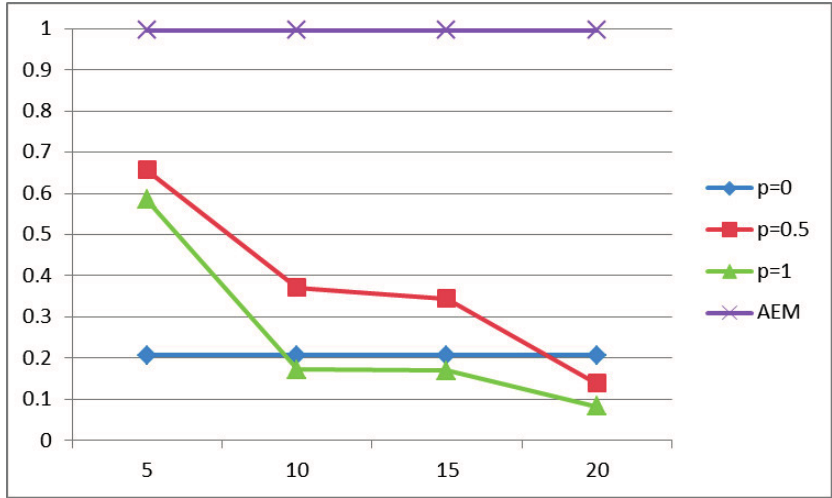
Figure 9. Probability of successful delivery of packets.